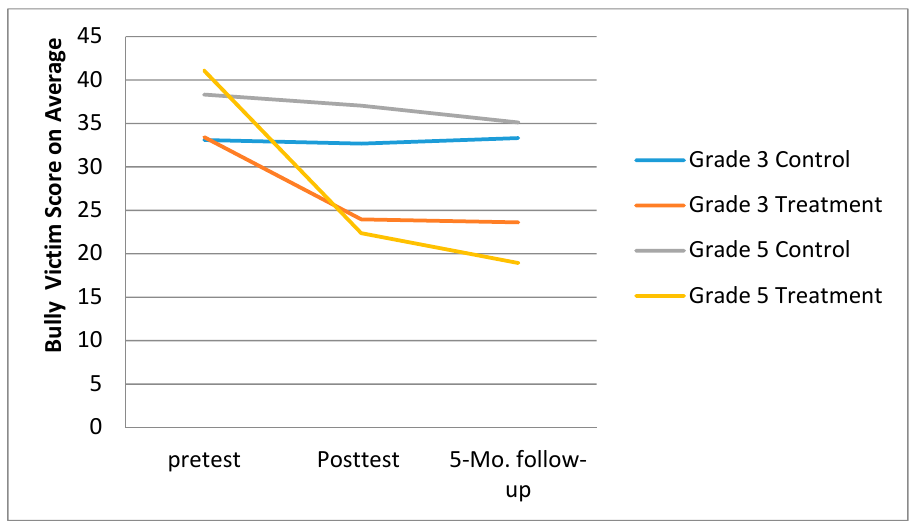
Figure 2. Comparison of bullying victimization scores at three time points for third- and fifth-grade students.